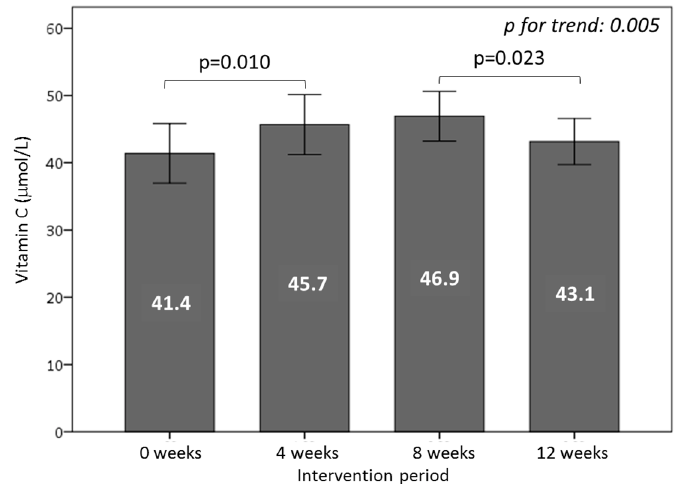
Figure 2. Effect of the consumption of burgers on plasma vitamin C throughout the study. Volunteers consumed one WGPF-burger daily between weeks 0 and 4 (intervention period), followed by a washout period (weeks 4 to 8), and then consumed one control-burger daily between weeks 8 and 12 (control period). Bars represent the mean value for each time; lines represent the 95% confidence interval. Analysis of variance (ANOVA) of four repeated measures with the repeated contrast method was used to evaluate changes between the 4-week intervention periods over time.